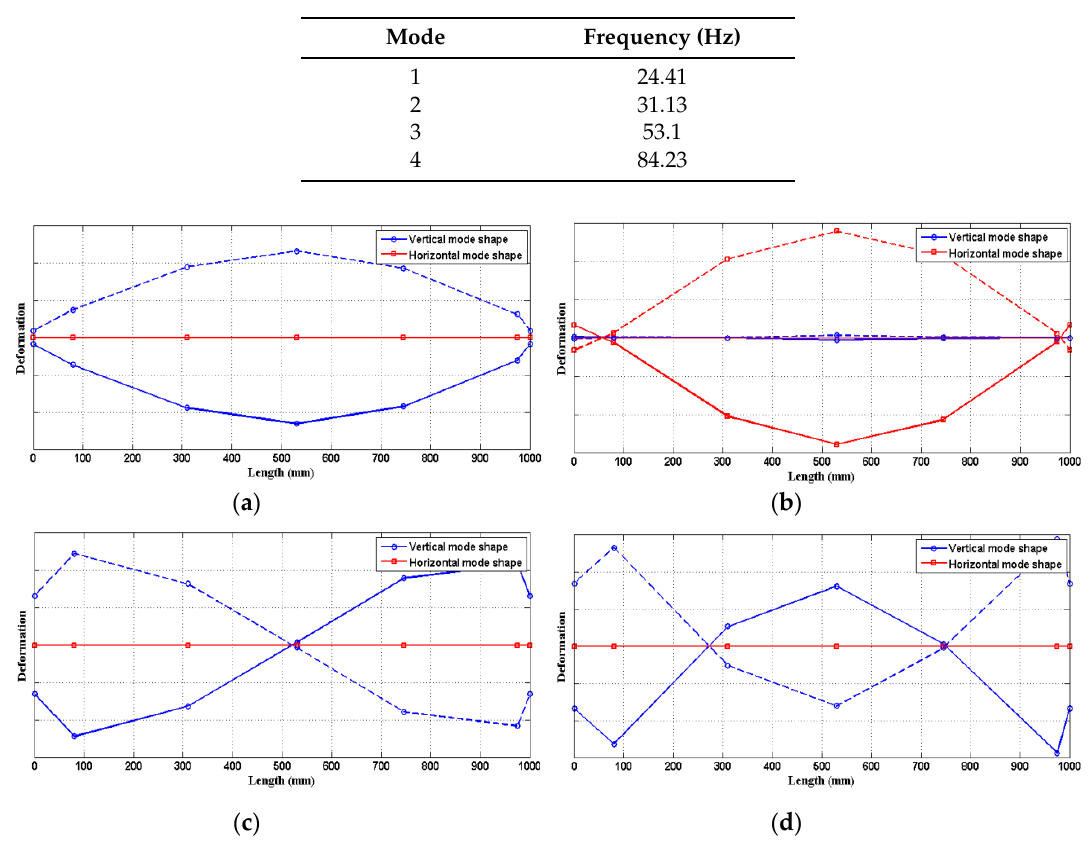
Table 1. Experimentally identified natural frequencies of the test rig.